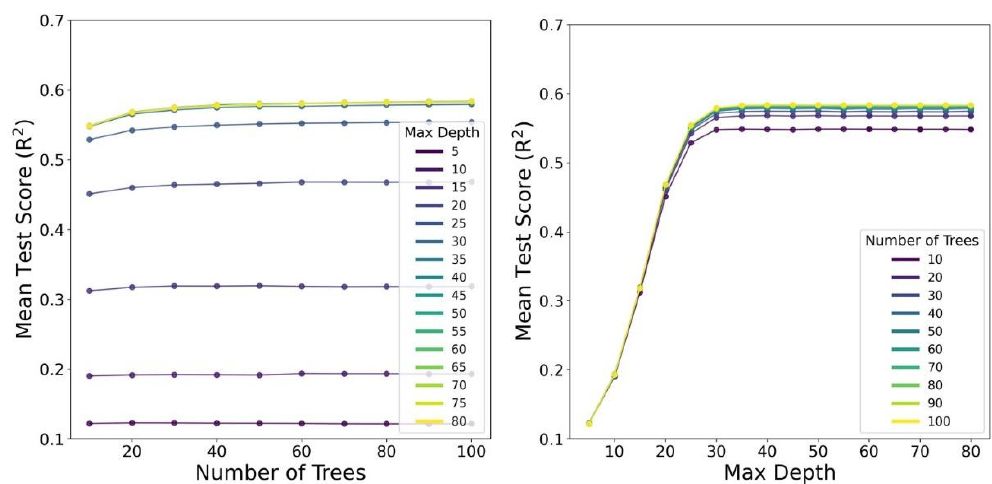
Figure 4. The impact of the number of trees ( left ) and the max depth of individual trees ( right ) on the R 2 of the test data set (20 cm).